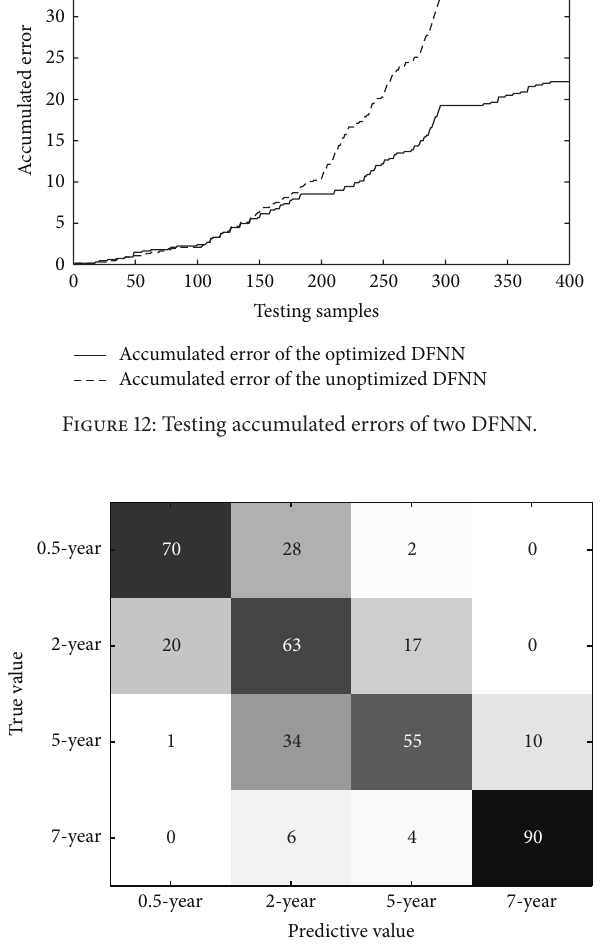
Figure13:BPneuralnetworkconfusionmatrixfortrainingsamples.